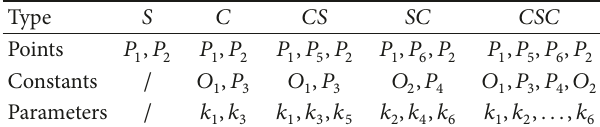
Table 1: Points for other Dubins